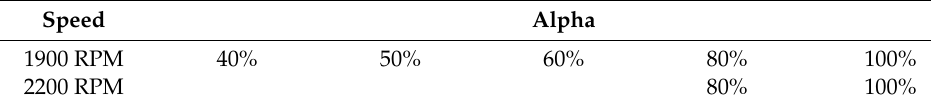
Table 2. Engine operating points.